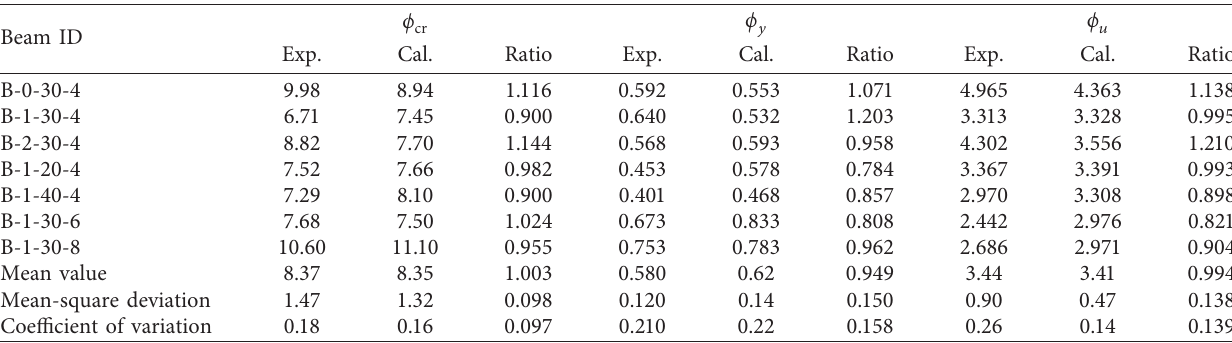
Mean value 30.33 Mean-square deviation 5.17 Coefficient of variation 0.17 Table 6: Experimental and calculated values of cracking curvature, yield curvature, and ultimate curvature of members. ϕ y ϕ u ϕ cr Beam ID Exp. Cal. Ratio Exp. Cal. Exp. Cal.